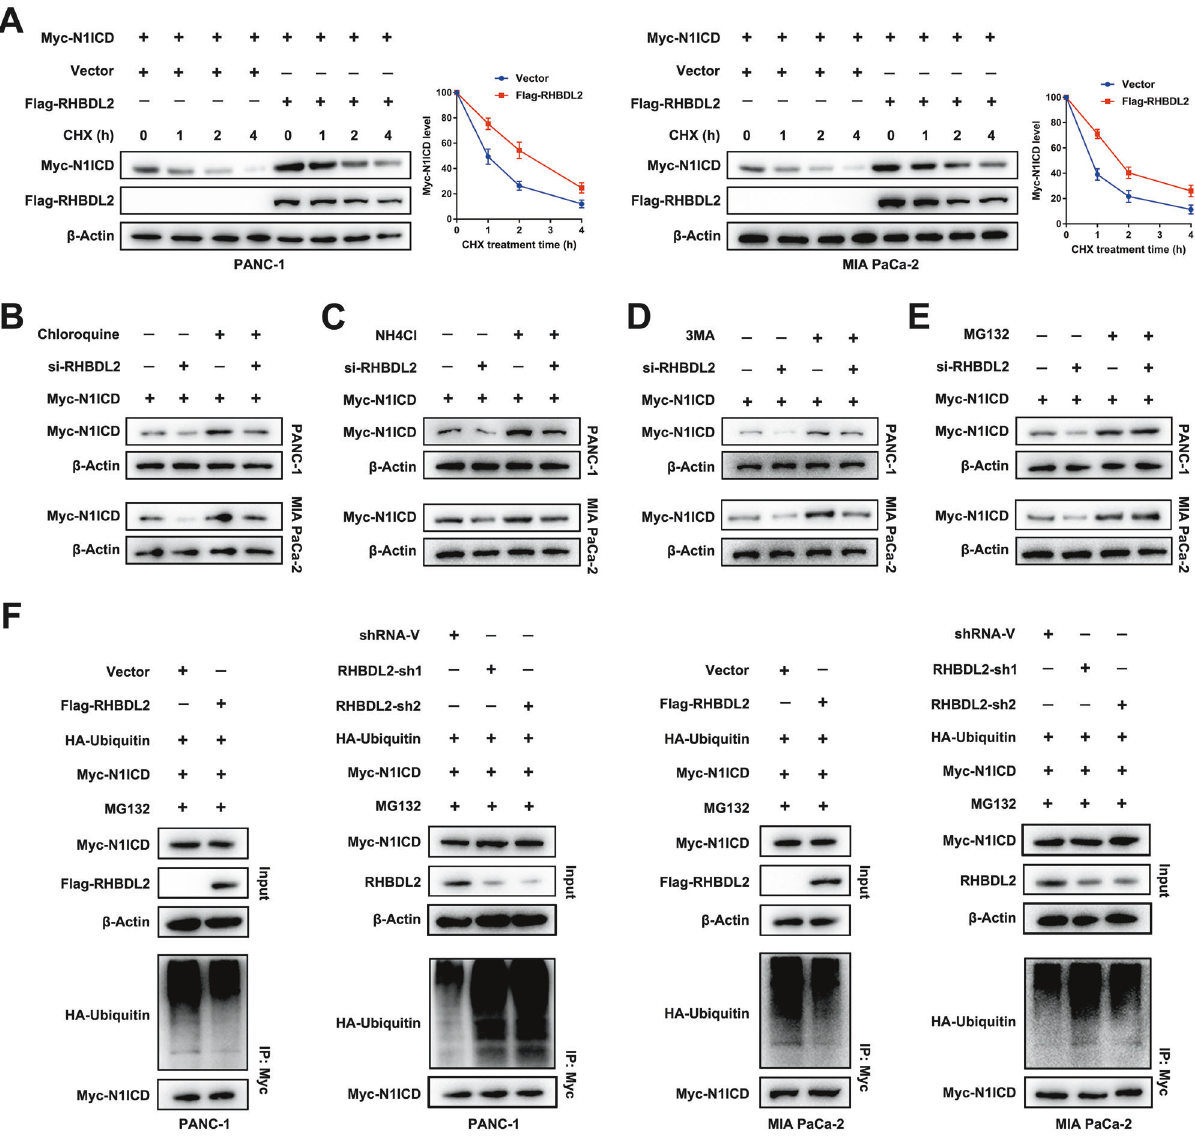
Fig. 5 RHBDL2 inhibits the degradation of N1ICD via ubiquitin-proteasome pathway. A N1ICD and RHBDL2 levels were con fi rmed by Western blot analysis in the indicated PC cells treated with 40 μ g/ml of cycloheximide (CHX). The indicated PC cells were treated with chloroquine ( B ), NH 4 Cl ( C ), 3-MA ( D ), or MG132 ( E ), respectively. Then, the level of N1ICD was detected by Western blot analysis. F The PC cells were treated with 15 μ M of MG132 for 6 h prior to harvest. Cell lysate was immunoprecipitated with Myc-tag antibody and immunoblotted as